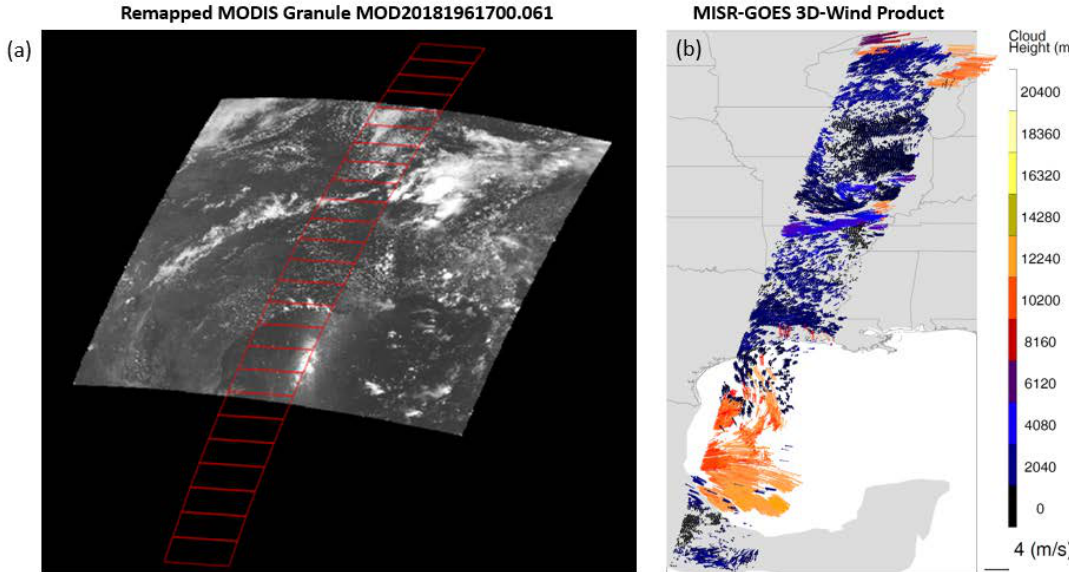
Figure 17. A MODIS granule that has been remapped into the GOES ABI fixed-grid projection is overlaid with red boxes at the left ( a ) showing the blocks in the MISR path intersecting the granule. The MISR-GOES 3D-wind product is shown at the right ( b ). The MODIS granule is MOD2018196.1700.061 (MODIS Band 1) and is simultaneous with MISR Path 24, Orbit 98797. (Note: retrieval sites are thinned 4:1 in each direction for clarity.).